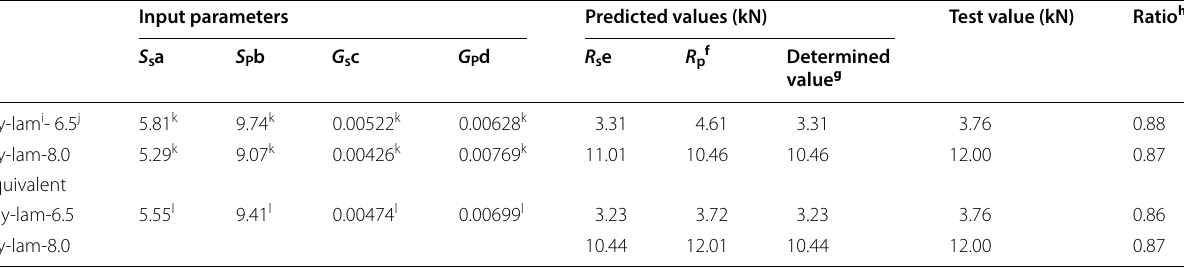
a S s = withdrawal strength of solid wood layer when a screw was pulled out (MPa) b S p = withdrawal strength of plywood layer when a screw was pulled out (MPa) c G s modified withdrawal stiffness for withdrawal behavior in solid wood layer (N/mm 3 ) = d G P = 0.17 em modified withdrawal stiffness for withdrawal behavior in plywood layer (N/mm 3 ) e